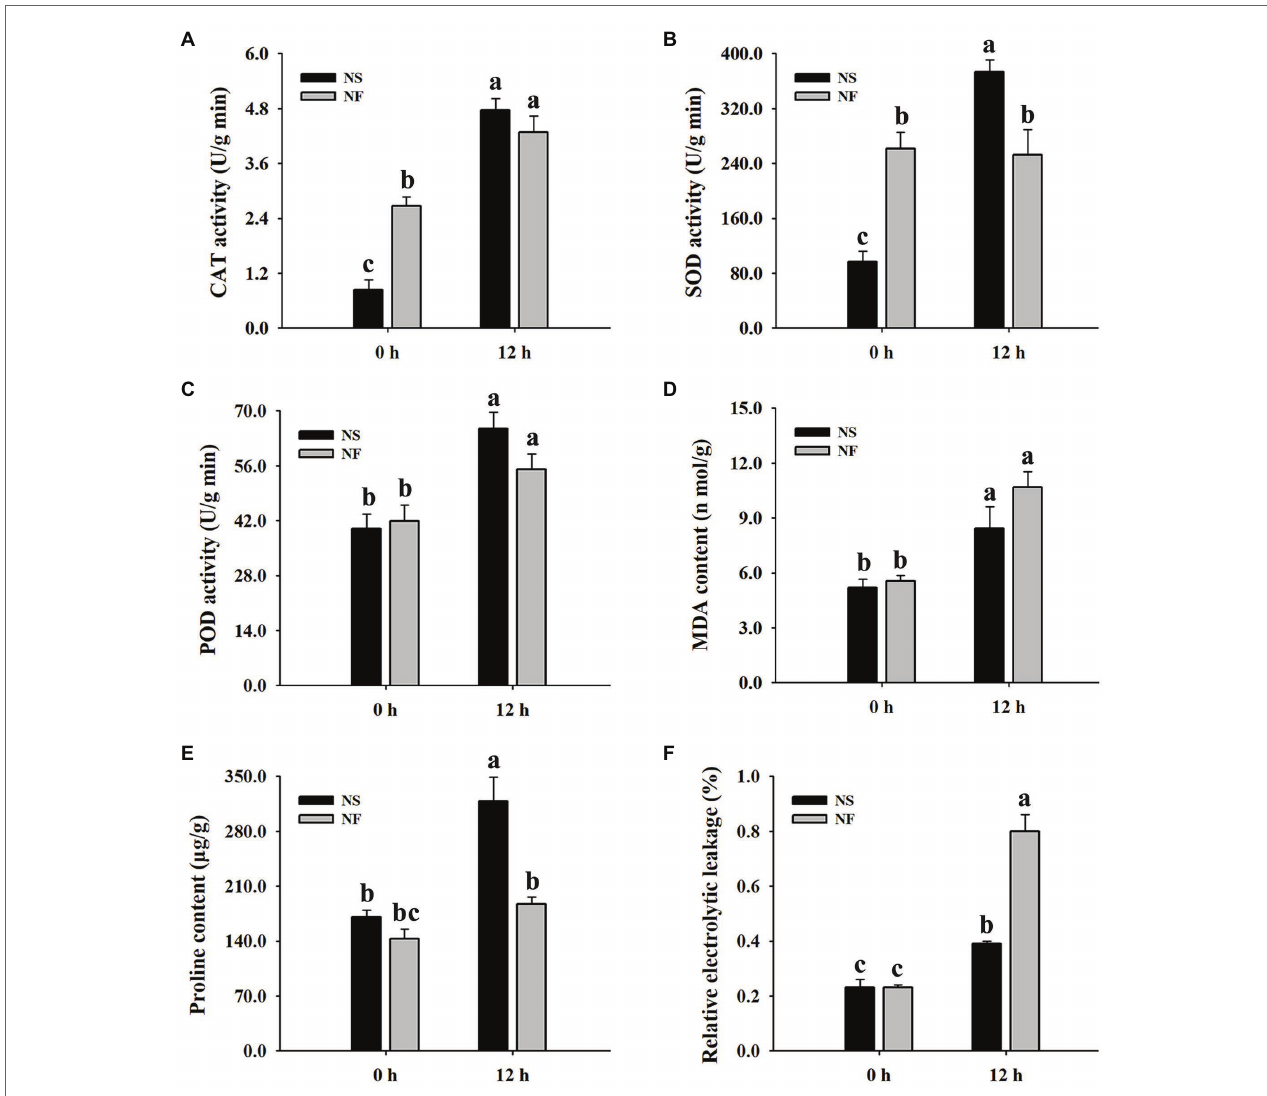
FIGURE 2 | Enzyme activities of catalase (CAT), superoxide dismutase (SOD), and peroxidase (POD), malondialdehyde (MDA) content, free proline content, and relative electrolyte leakage (REL) in the leaves of winter rapeseed under freezing treatment for 0 and 12 h, respectively. (A) CAT activity, (B) SOD activity, (C) POD activity, (D) MDA content, (E) free proline content, (F) REL. Values of p are means ± SD from three biological replicates ( p <